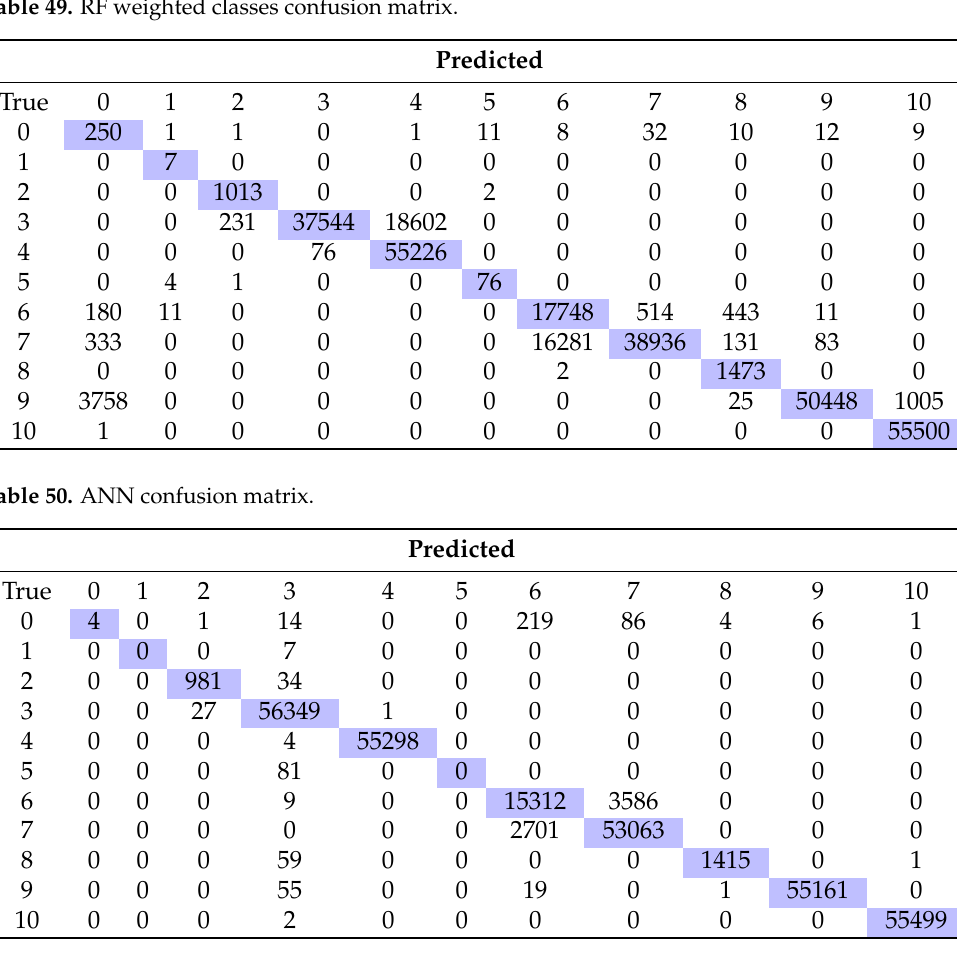
Table 49. RF weighted classes confusion matrix.